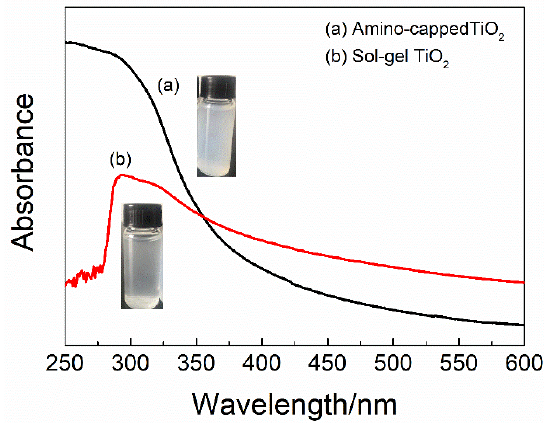
Figure 2. UV-vis spectra of ( a ) TiO 2 and ( b ) amino-capped TiO 2 colloidal solution. 3.2. Preparation and Characterization of the Cotton Fabric Coated by the Amino-Capped TiO 2 NPs